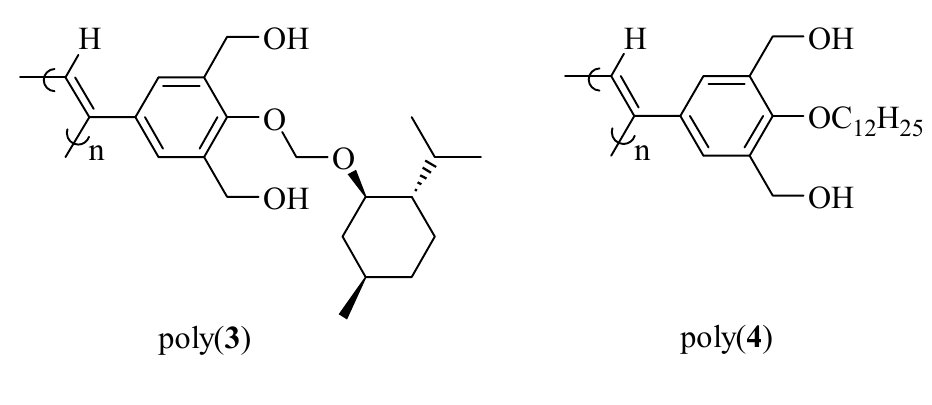
Figure 3. Chemical structures of poly( 3 ) and poly( 4